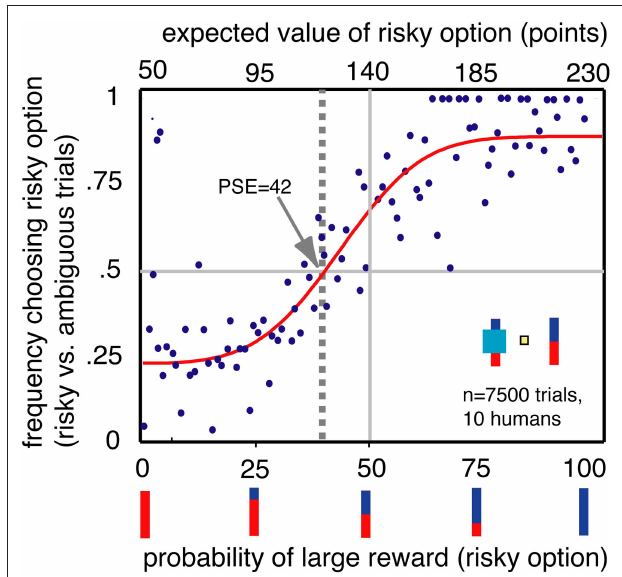
Figure 3 | Humans, like monkeys, preferred options with known probabilities. Conventions as in Figure 2A .